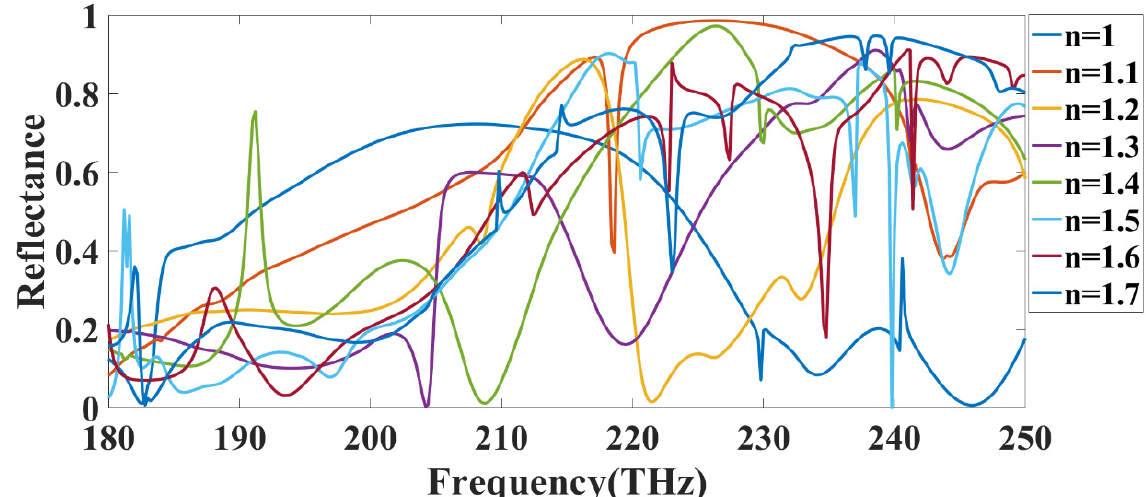
Figure 3. Variation in the reflectance for the different refractive index values.